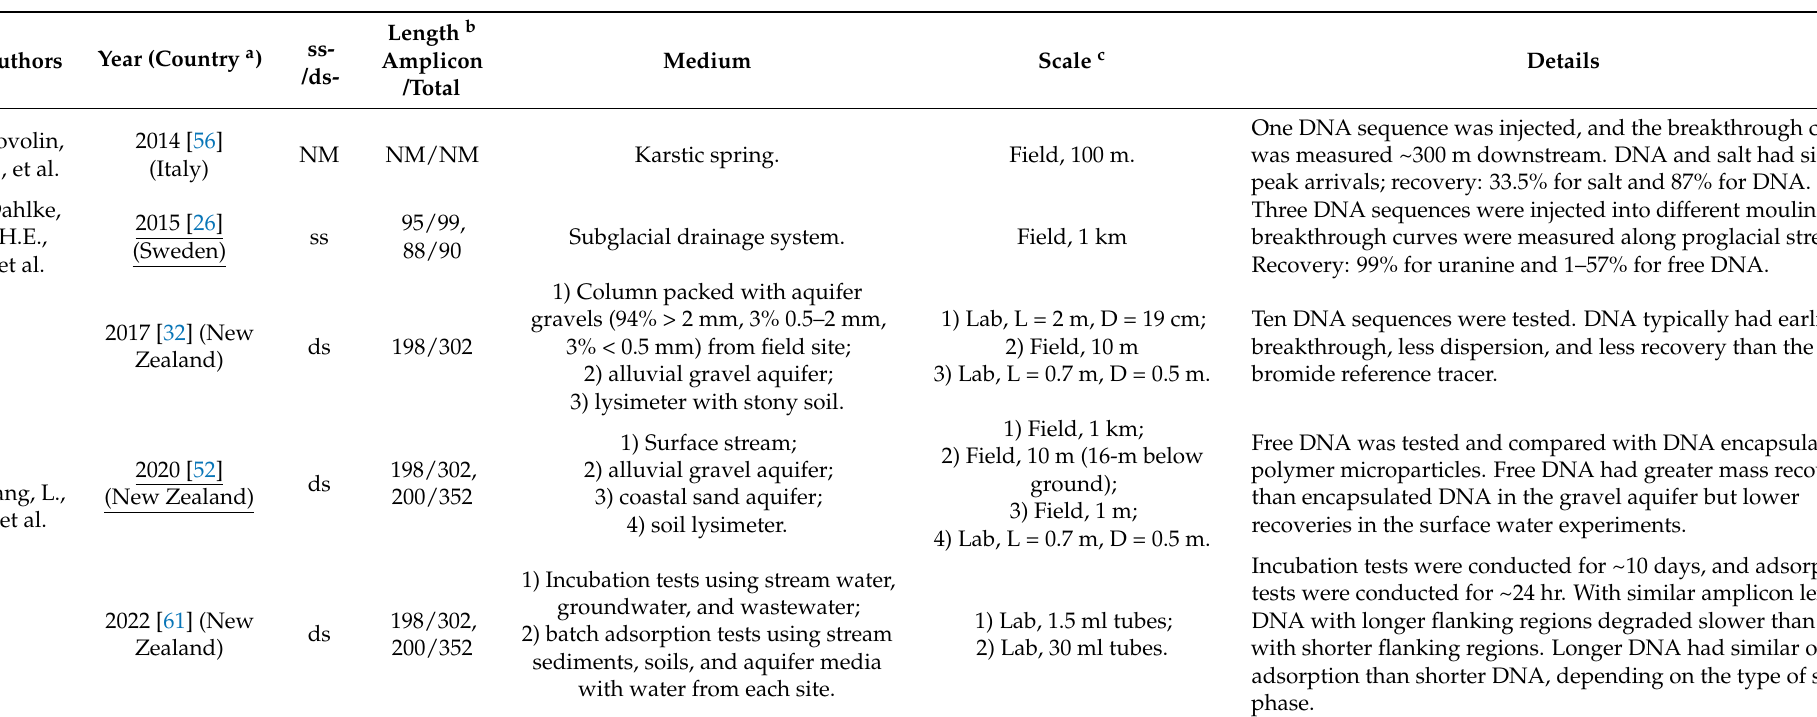
Karstic spring. Field, 100 m.